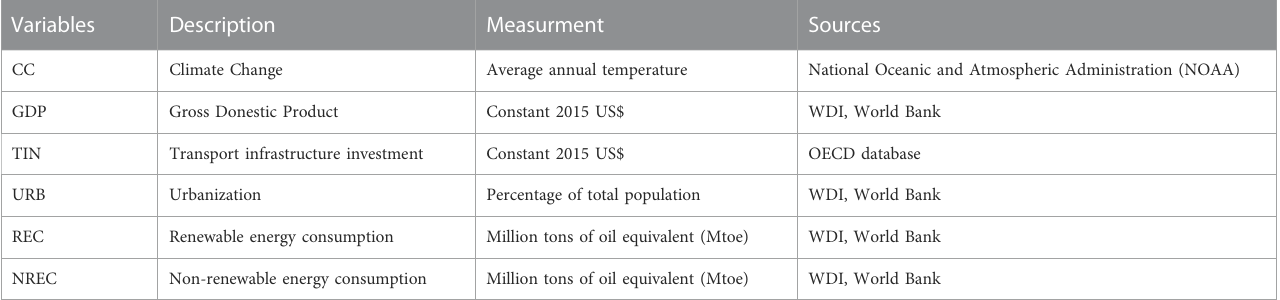
TABLE A1 Variable data sources, measurements and